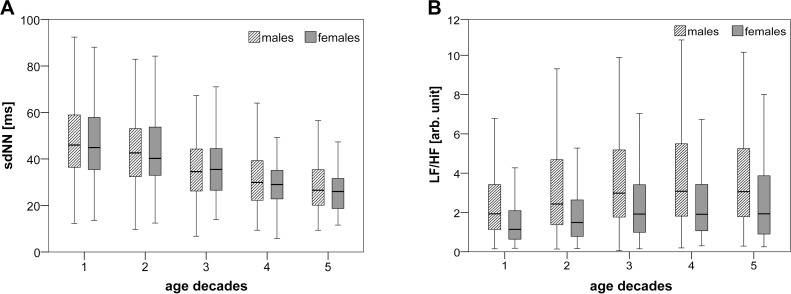
Box plots for sdNN and LF/HF for five investigated age decades divided by gender.The box plots show two selected HRV indices (A: sdNN (TD) and B: LF/HF (FD)) for the five investigated age decades (1: 25–34, 2: 35–44, 3: 45–54, 4: 55–64 and 5: 65–74 years) and divided into males (black cross-striped boxes) and females (white boxes). The boxes show the data between the 25th and 75 Percentile, the middle line represents the median.